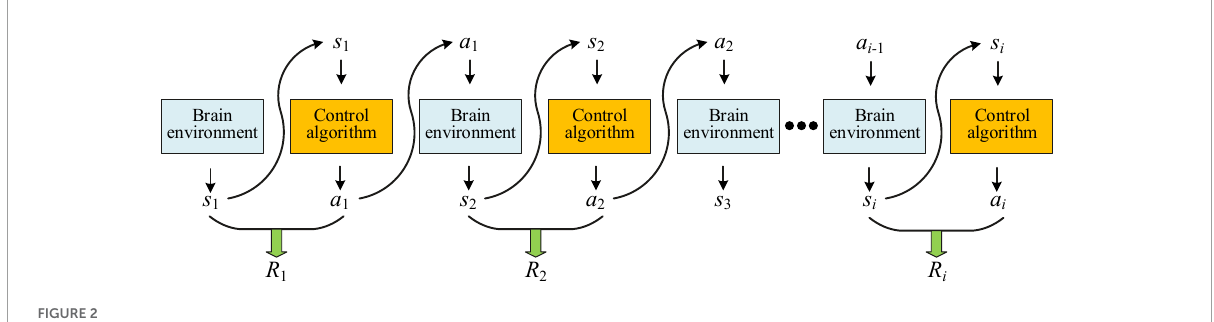
FIGURE2 Schematic diagram of Monte Carlo sampling in the PSA